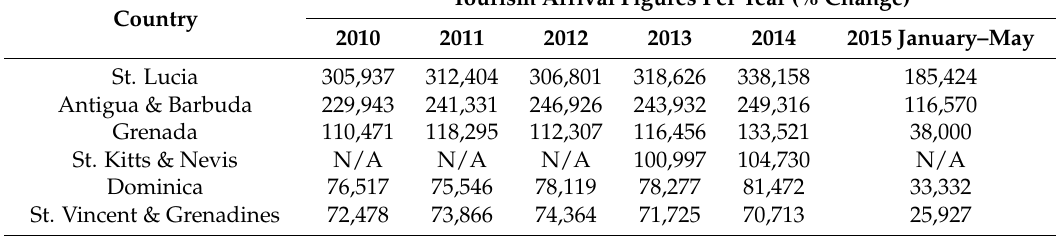
Table 1. The tourism arrival trends in the Independent Member States of the Organization of Eastern Caribbean Sates (OECS) during the period 2010–2015. Countries are ranked based on 2013 and 2014 arrival data (source: CTO,